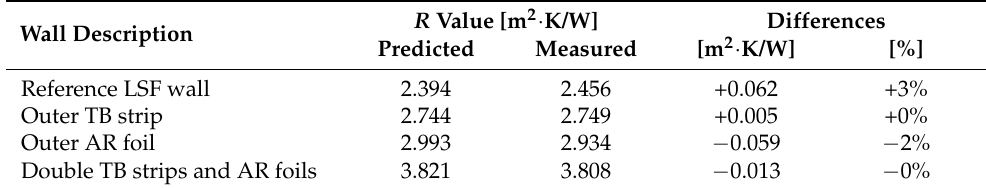
Table 3. Predicted and measured conductive thermal resistance of double-pane LSF walls. Absolute and percentage differences.